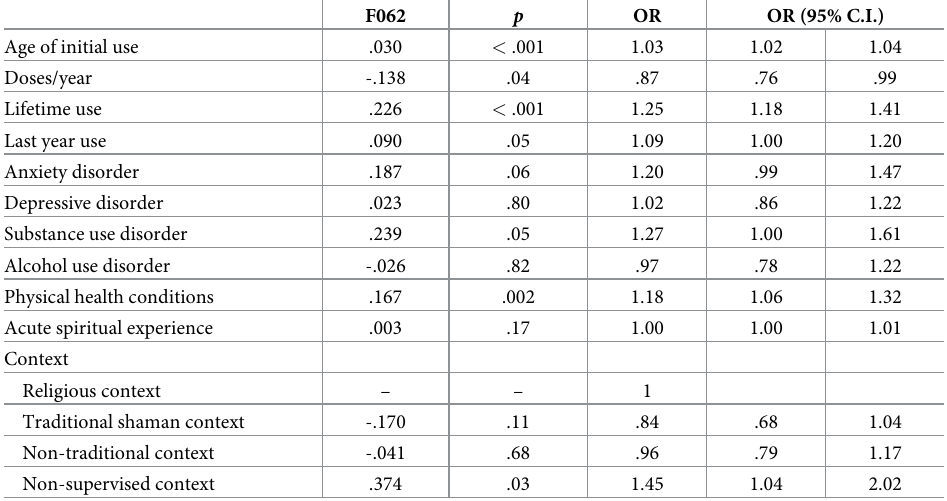
Table 4. History of ayahuasca use and medical status variables’ relationships with the presence of adverse physical effects. F062 p